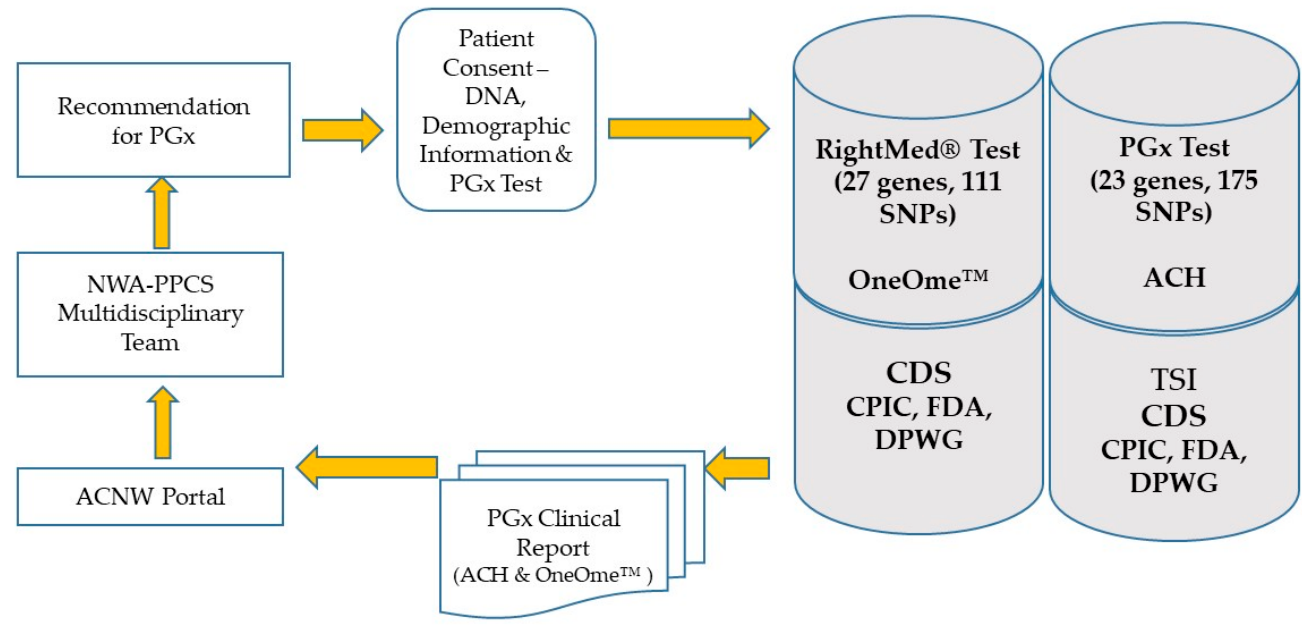
Figure 1. Study design for ACNW pilot project. All patients were under 21 years old, had a PGx test as part of their clinical care, and had a consultation with the NWA-PPCS. PGx = pharmacogenomics; ACNW = Arkansas Children’s Northwest; ACH= Arkansas Children’s Hospital; TSI = Translational Software, Inc., (Bellevue, WA, USA); CDS = clinical decision support; CPIC = Clinical Pharmacogenetics Implementation Consortium; DPWG = Dutch Pharmacogenetics Working Group; FDA = Food and Drug Administration.